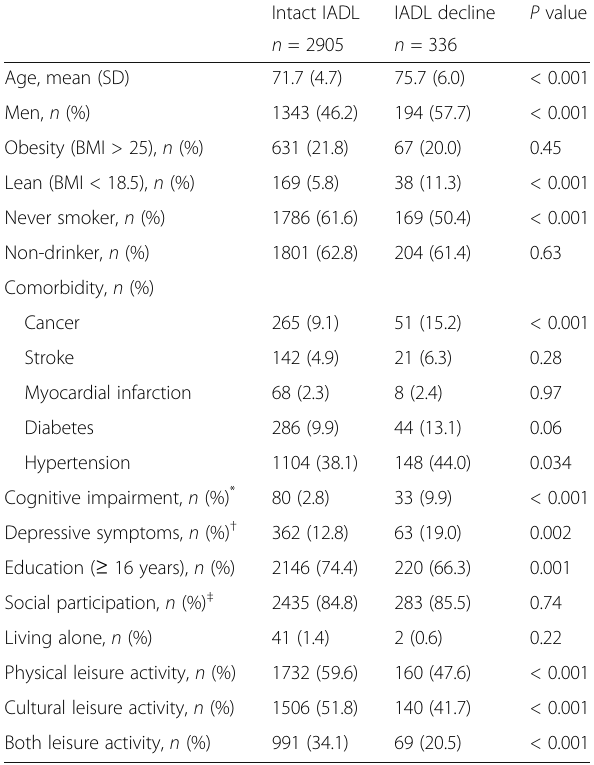
Table 1 Baseline characteristics by the incident of IADL decline during 5 years